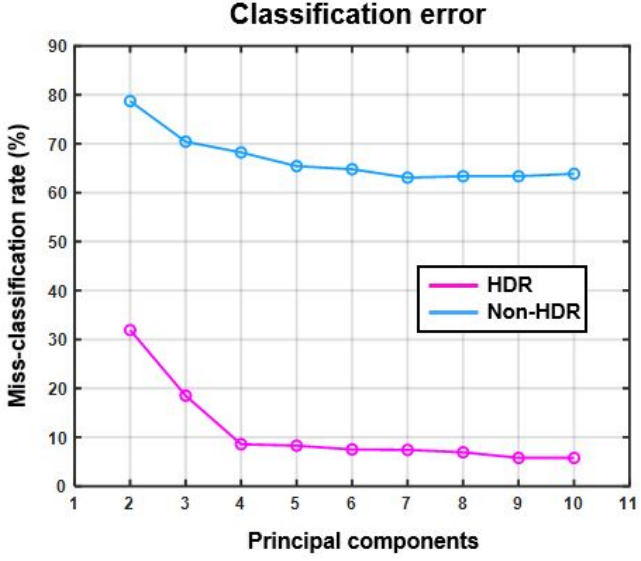
Figure 13. Miss-classification rate (%) vs. number of principal components (test case 2).